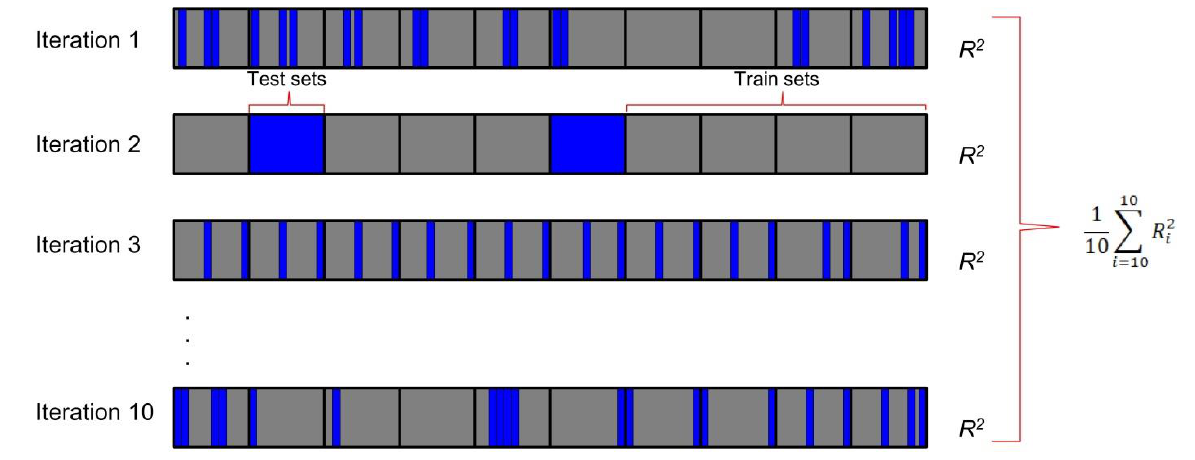
Figure 5. Monte-Carlo Cross-Validation.